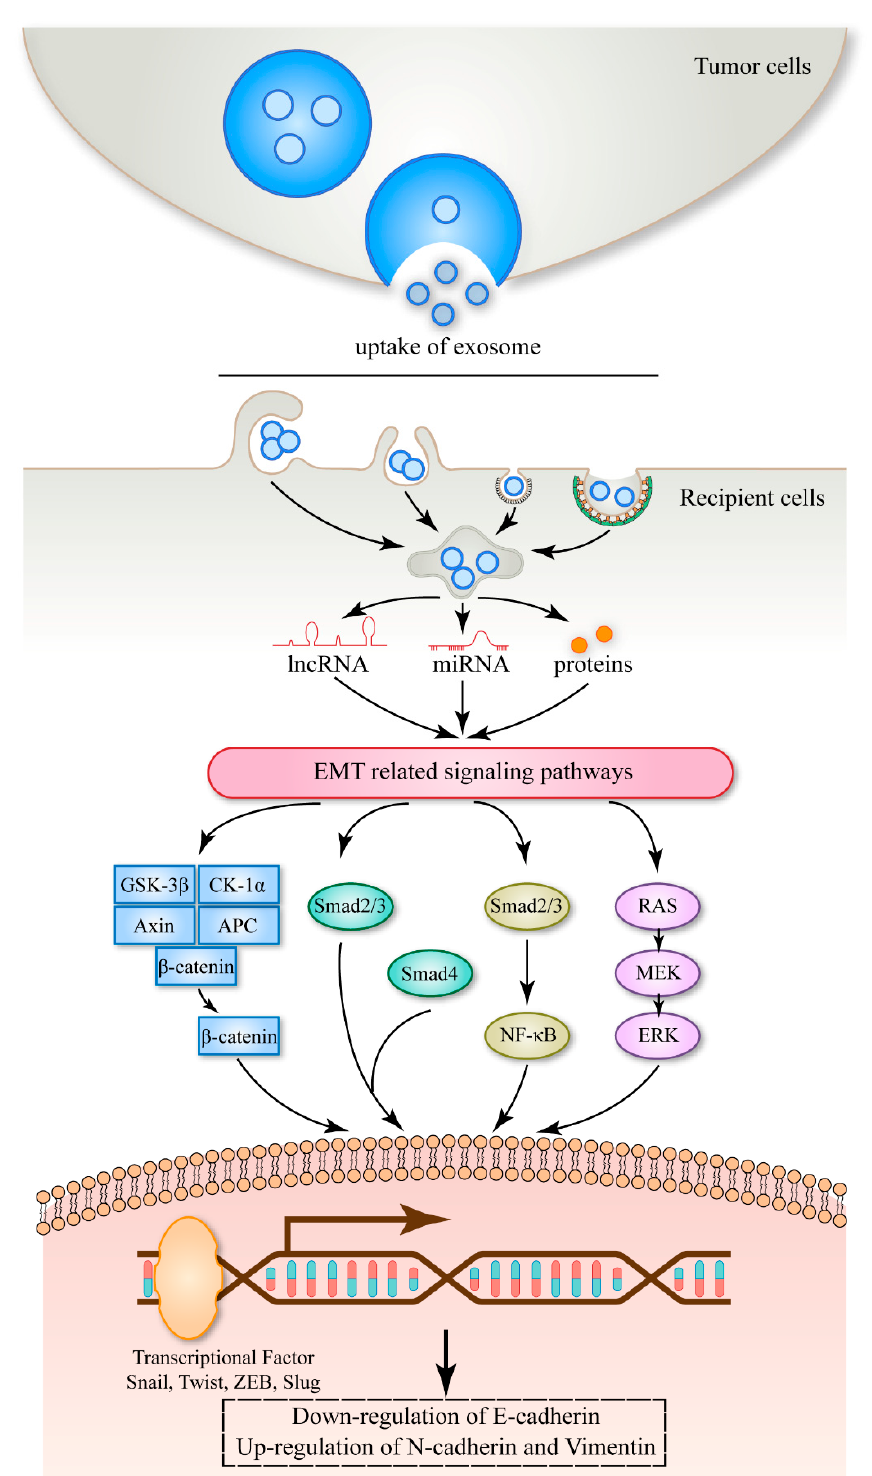
Figure 3. A schematic model of tumor-derived exosomes dysregulating cadherin expression. Tumor-derived exosomes deliver miRNA, lncRNA, and proteins to recipient cells, stimulate EMT-related signaling pathways, down-regulate the expression of E-cadherin, and up-regulate the expression of N-cadherin and vimentin, and further promote tumor progression.